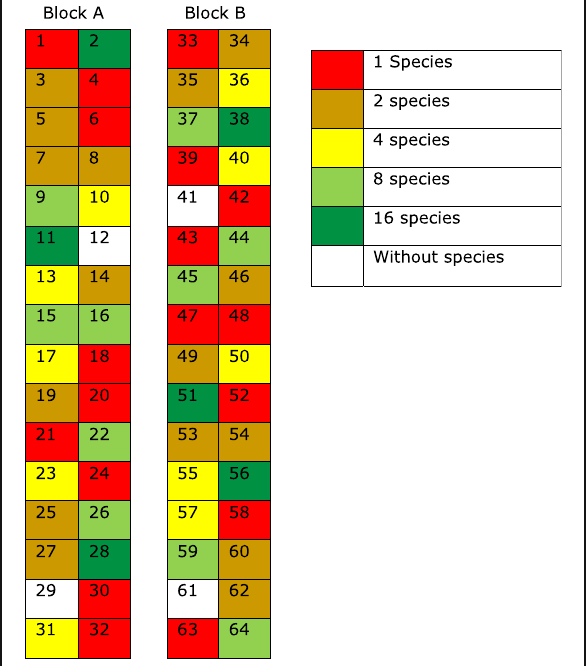
Fig. 1 Initial experimental design of the BIODEPTH experiment with blocks A (1 – 32) and B (33 – 64). Each color represents the initial levels of species diversity for each